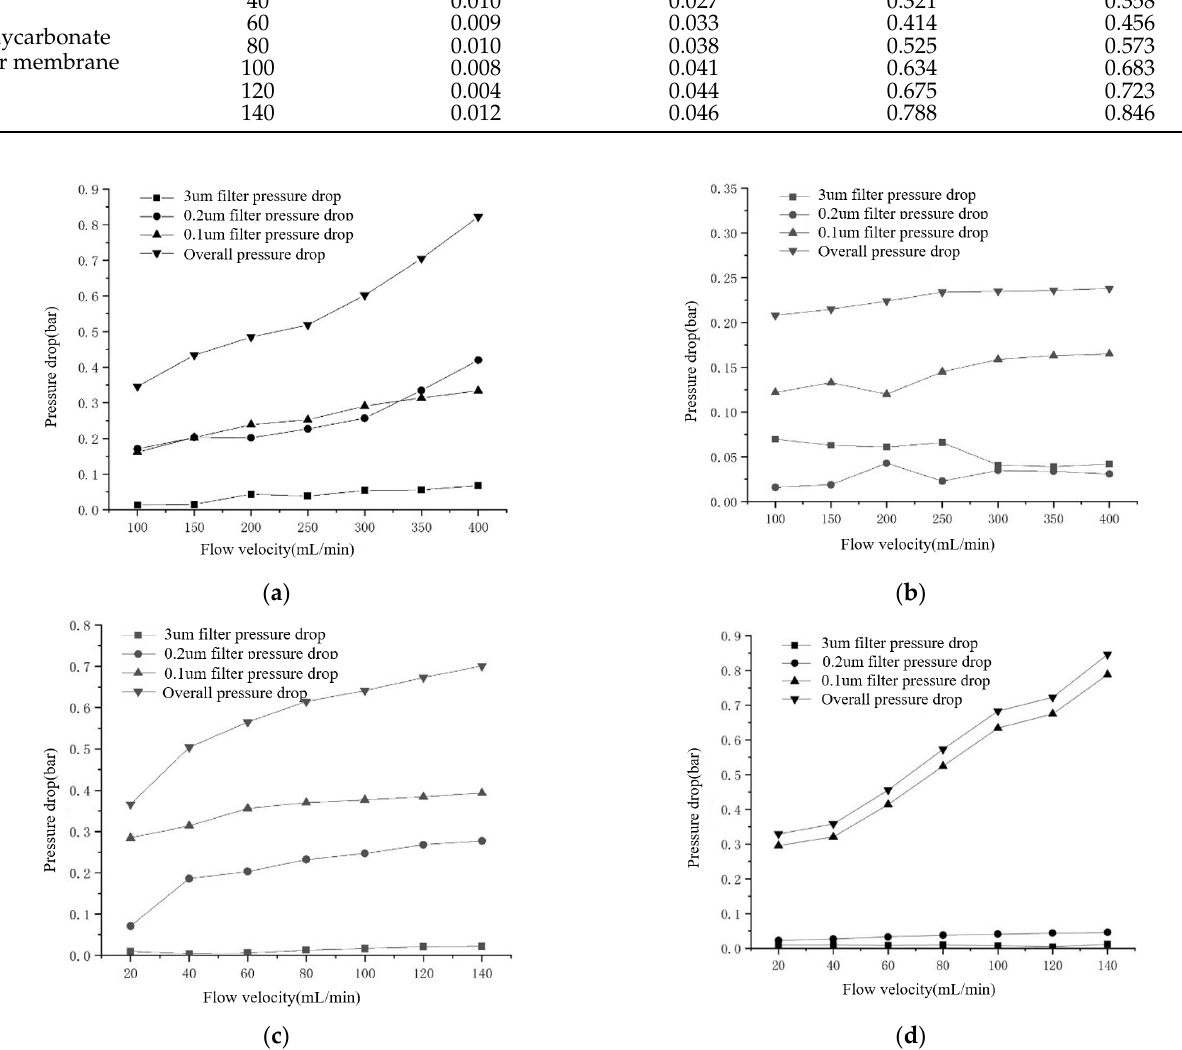
Figure 11. Flow velocity–pressure drop curves of four kinds of filters. ( a ) Flow velocity–pressure drop curve of mixed cellulose ester filter membrane ( b ) Flow velocity–pressure drop curve of glass fiber filter membrane ( c ) Flow velocity– pressure drop curve of the polypropylene filter membrane ( d ) Flow velocity–pressure drop curve of the polycarbonate filter membrane. Table 3. Flow velocity–pressure drop of four kinds of filter membranes.